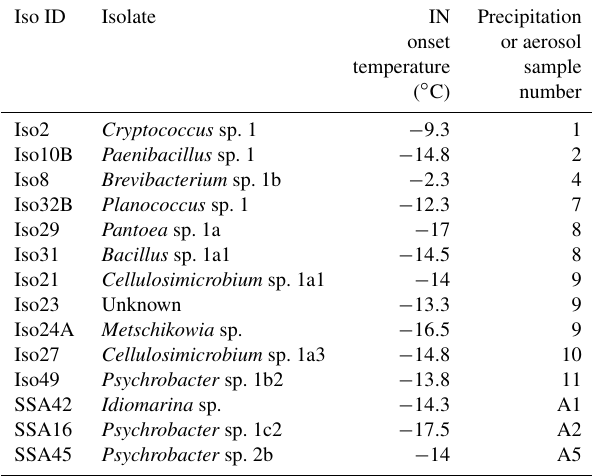
Table 1. Identities of 14 cultivable halotolerant IN bacteria and fungi derived from aerosol and precipitation samples (see Table S2 for precipitation and aerosol sample